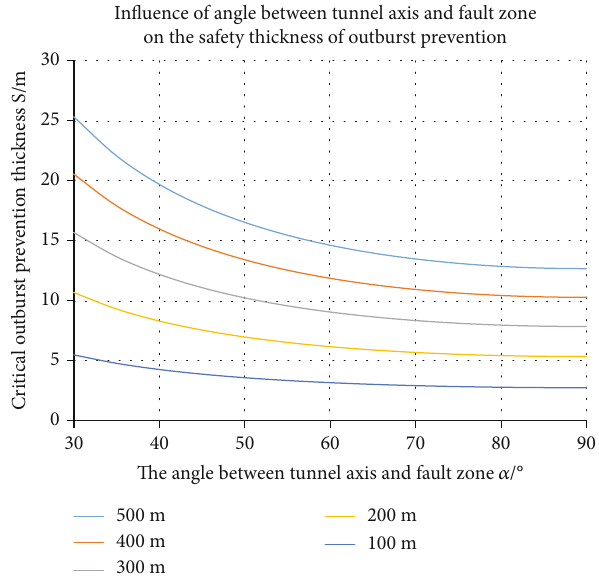
Figure 4: In fl uence of angle between tunnel axis and fault zone on the safety thickness of outburst prevention.